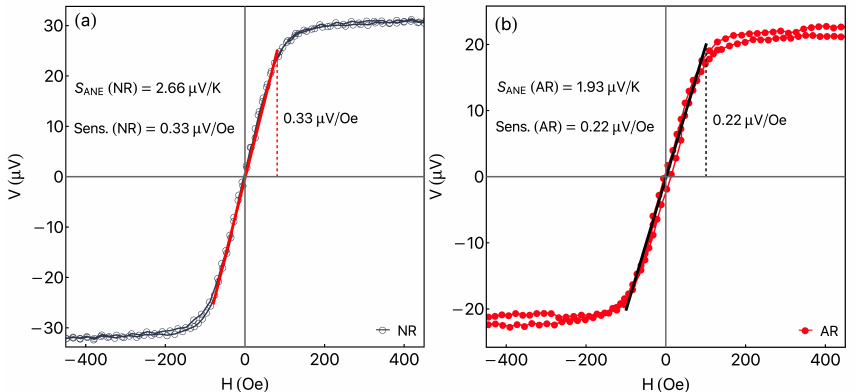
Figure 8. ( a ) Anomalous Nernst Effect response for the NR ribbon as a function of the magnetic field for ∆ T = 22 K. The red line is the linear fit between ± 80 Oe where the thermomagnetic response presents a linear behavior. From the fitting, it is possible to calculate the ANE sensitivity of 0.33 µ V/Oe for the NR ribbon. ( b ) A similar plot for the AR ribbon measured at ∆ T = 18.5 K, revealing a sensitivity of 0.22 µ V/Oe for the AR